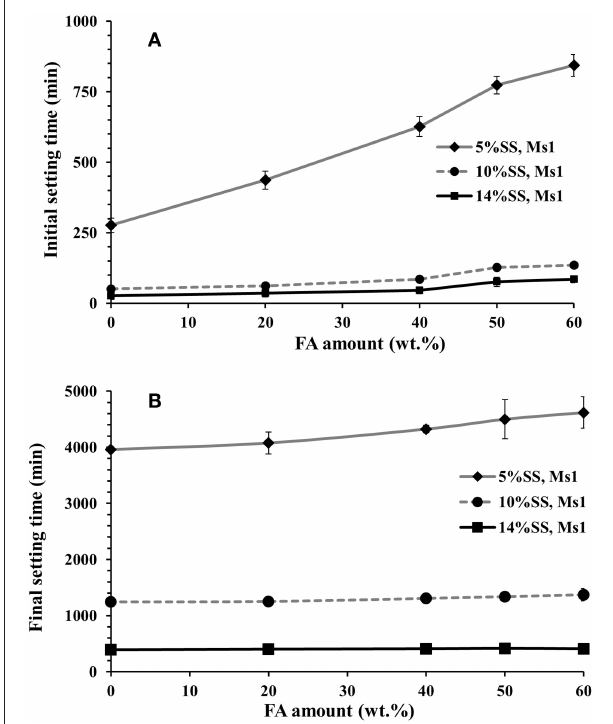
FIGURE 1 | (A) Initial setting times, (B) final setting times of pastes activated with 10 wt.% sodium silicate (SS) and different alkali modulus M s .